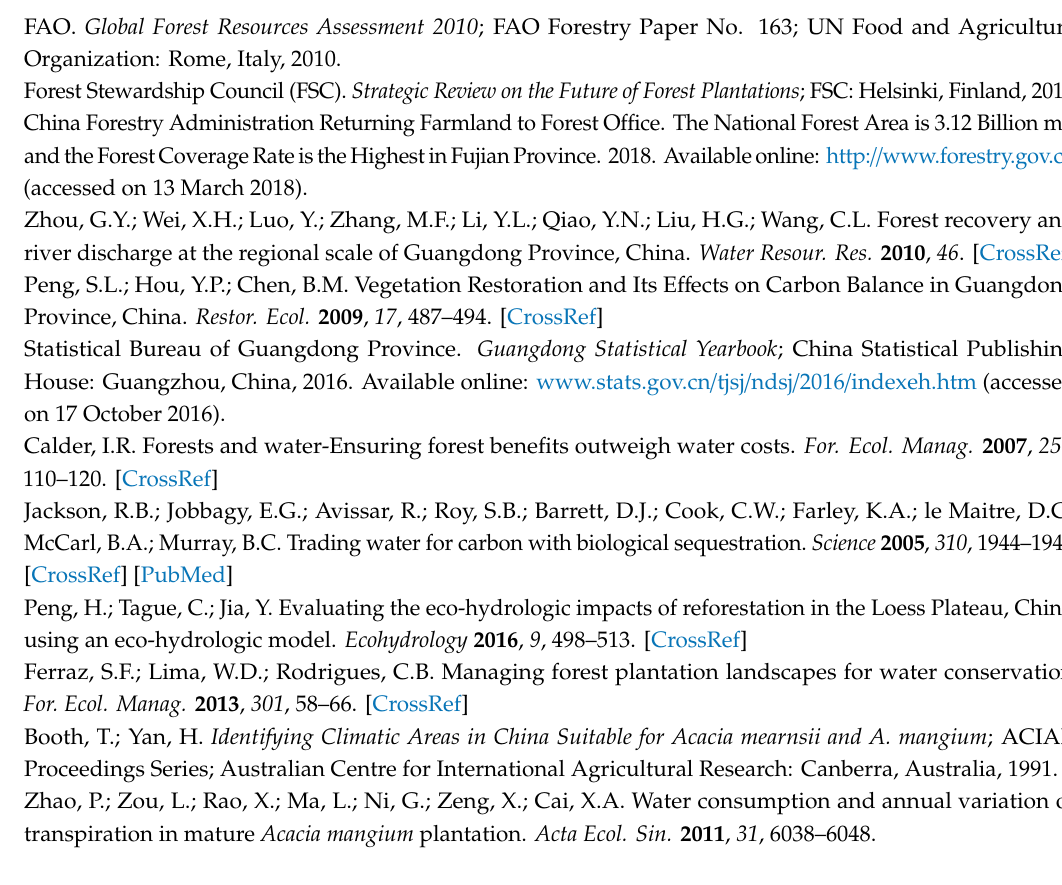
Table S1: 95% confident interval of model relating daily sap flow density ( J s ) to environmental factors in di ff erent seasons and species. Table S2: 95% confident interval of model relating hourly sap flow density ( J s ) to environmental factors in di ff erent seasons and